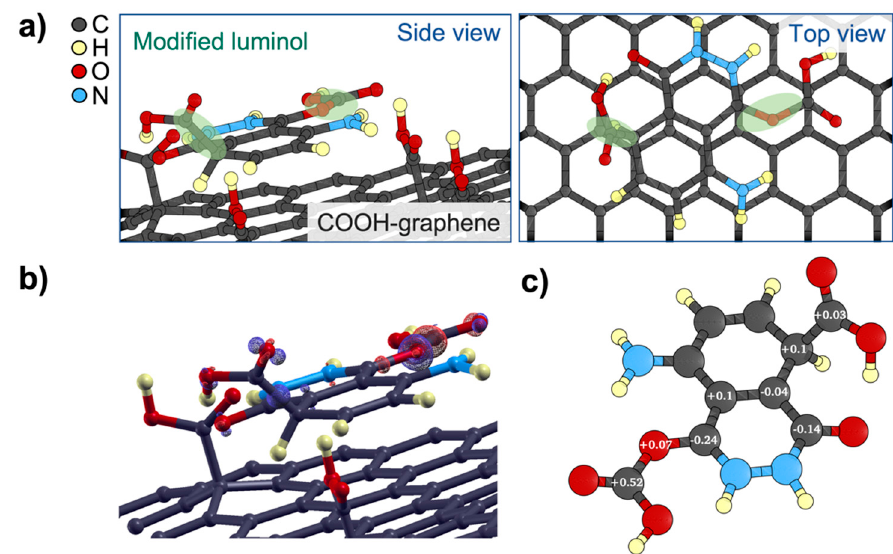
Figure 1. ( a ) Schematic of side (left) and top (right) views of the structural arrangement of luminol adsorbed on COOH-graphene in the interstitial configuration, ( b ) 3D difference charge density plot of luminol adsorbed on COOH-graphene corresponding to the ± 0.2 eV/Å 3 isosurface. Blue and red wire mesh surfaces correspond to regions of electron accumulation and depletion, respectively. ( c ) Most significant differences in Bader ionic charges following adsorption and chemical modification of luminol. A positive value indicates an increase in positive ionic charge, and vice versa, in units of fundamental charge (e).